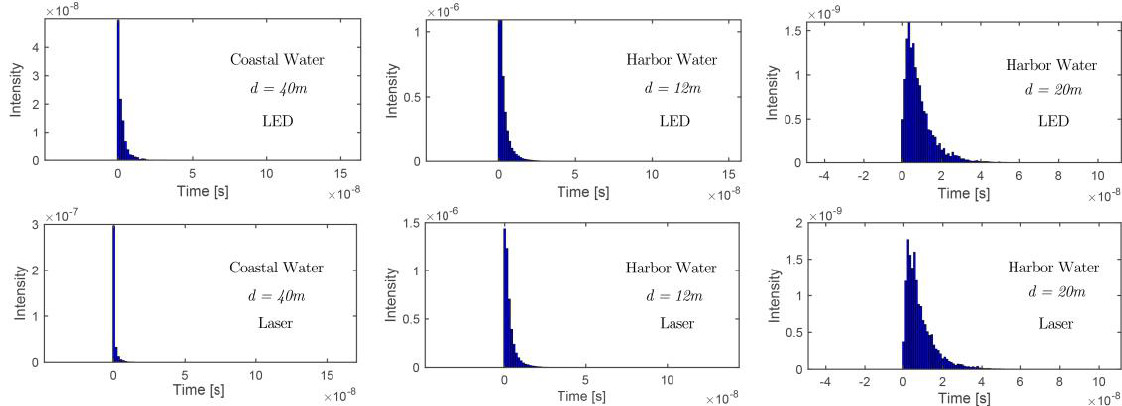
Figure 6. Illustration of CIR histogram of diffusive and collimated links for coastal & harbor water.